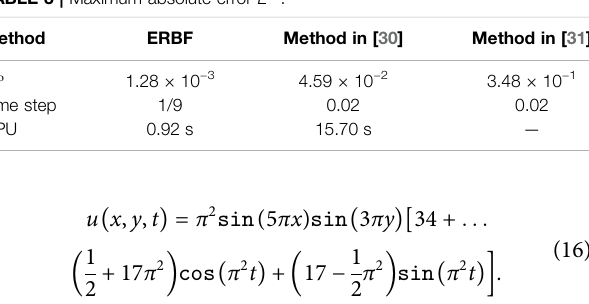
TABLE 3 | Maximum absolute error L ∞